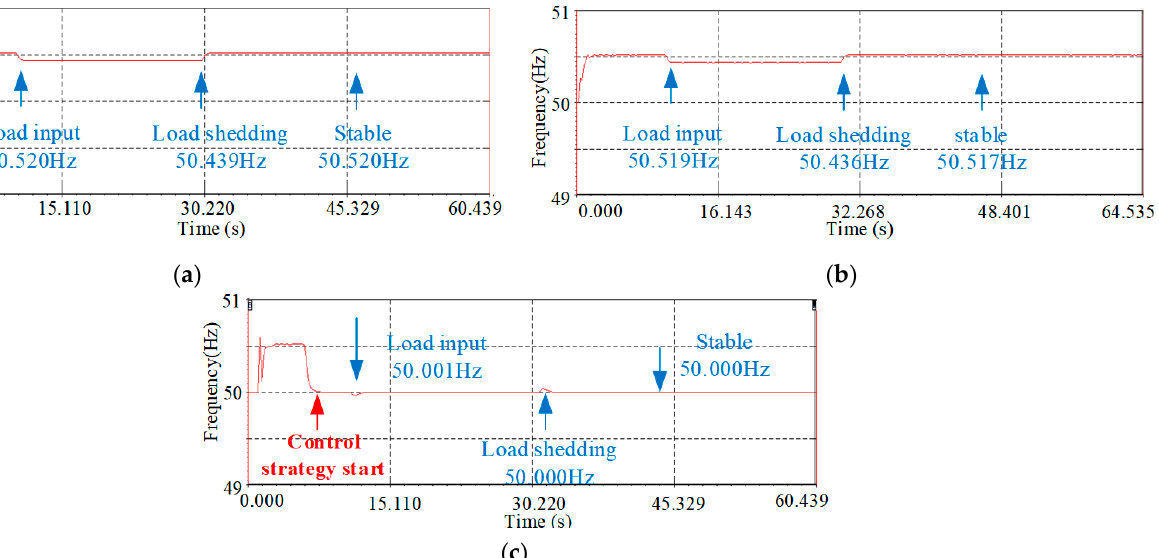
( b ) Figure 13. Experimental results for the voltage waveform of microgrid for PCC point ( a ) without the harmonic voltage suppression of multi-inverter parallel VSG adding a secondary control strat- egy; ( b ) with the harmonic voltage suppression of multi-inverter parallel VSG adding a secondary control strategy. As shown in Figure 14, frequency deviates from the standard value, and frequency